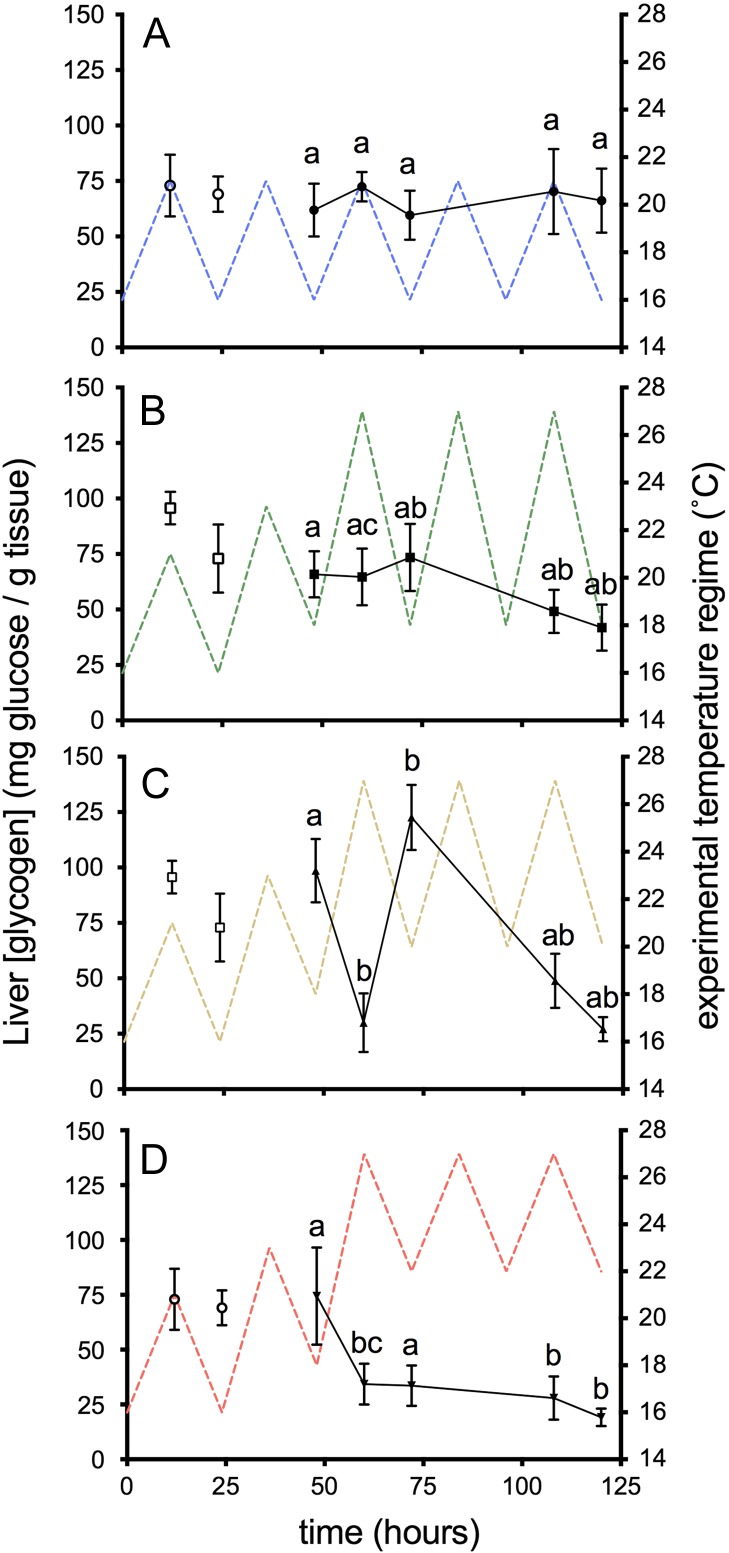
Liver glycogen in juvenile salmon exposed to diel cycles: (A) 16–21°C (control group); or multi-day thermal stress (60–120 h) of (B) 18–27°C; (C) 20–27°C; (D) 22–27°C. Data are presented as mean ± SEM (n = 6–9). Pre-thermal stress sampling (t = 12 and 24 h) assessed the effect of ‘trial’ and was not included in the analysis. Letters indicate significant differences among treatments (P < 0.05) within sampling time points.